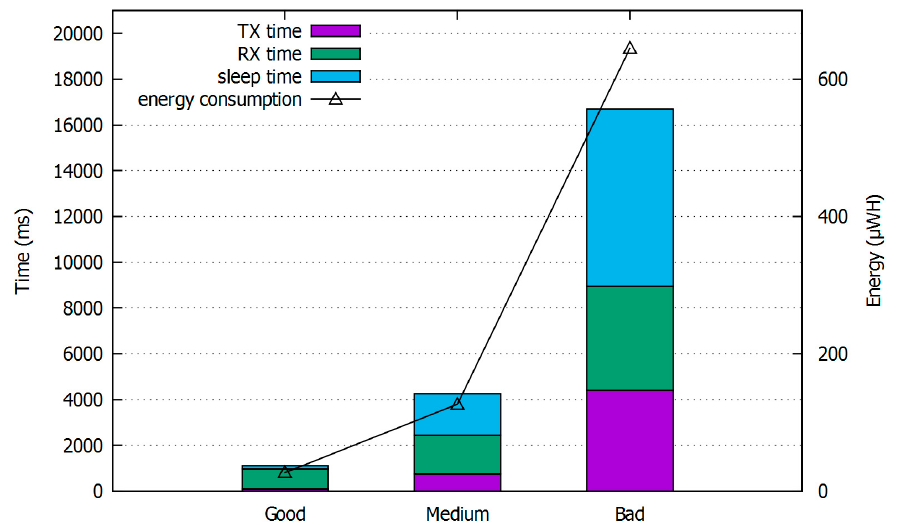
Figure 13. Active time and energy consumption for UE report scenario.